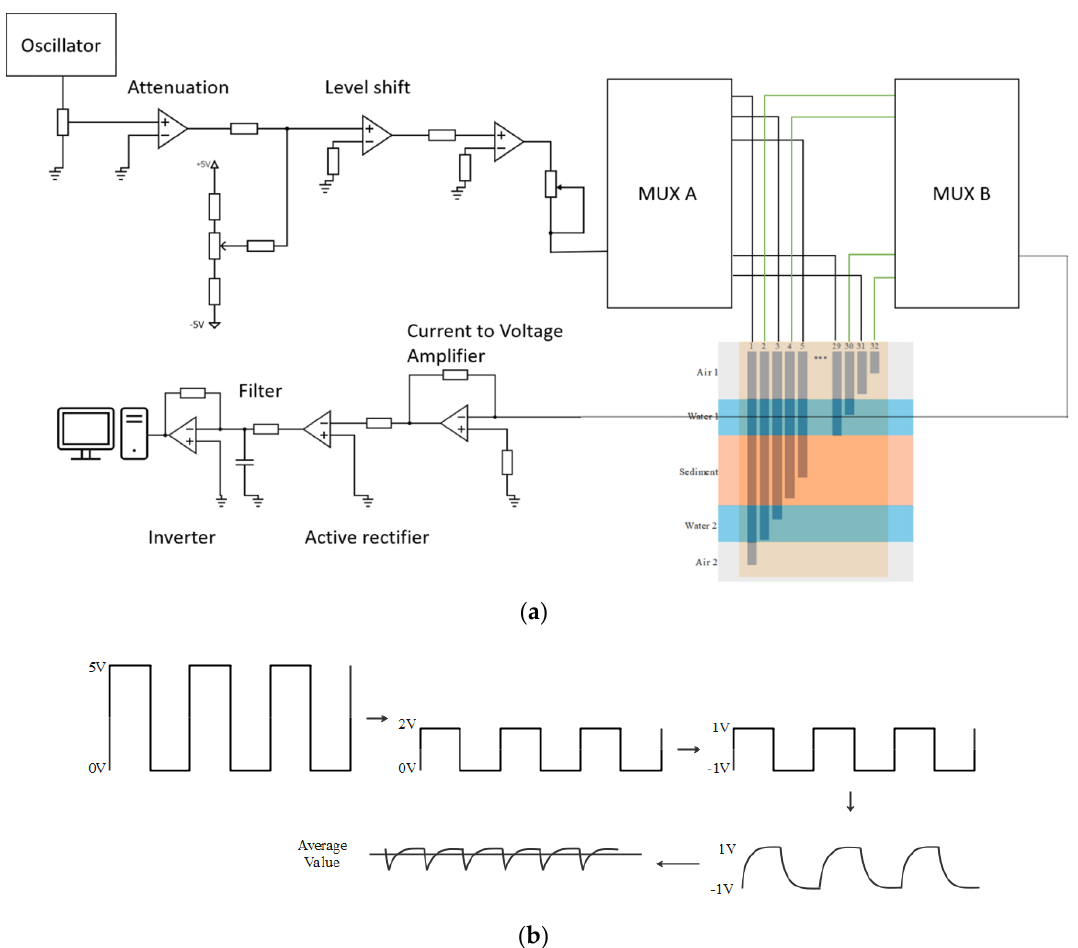
Figure 6. ( a ) Schematic diagram of the simplified measurement circuit; ( b ) Wave form changes in measuring circuit.